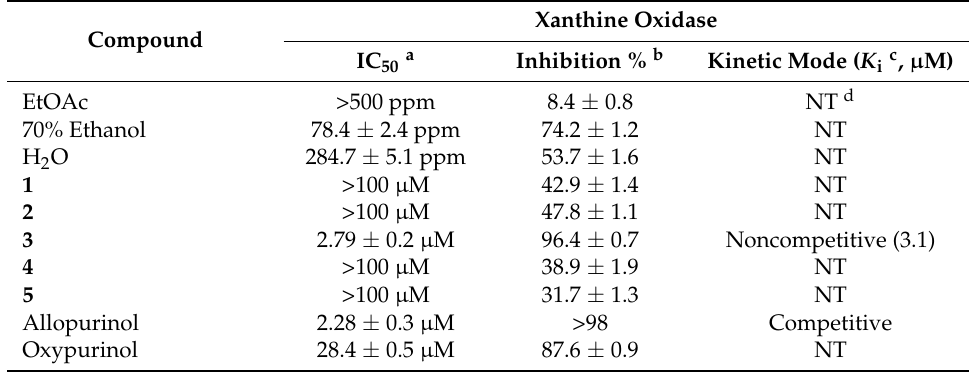
Table 1. Inhibitory effects of the leaf extract of Toona sinensis using different solvents and isolated compounds 1 − 5 on xanthine oxidase activities.